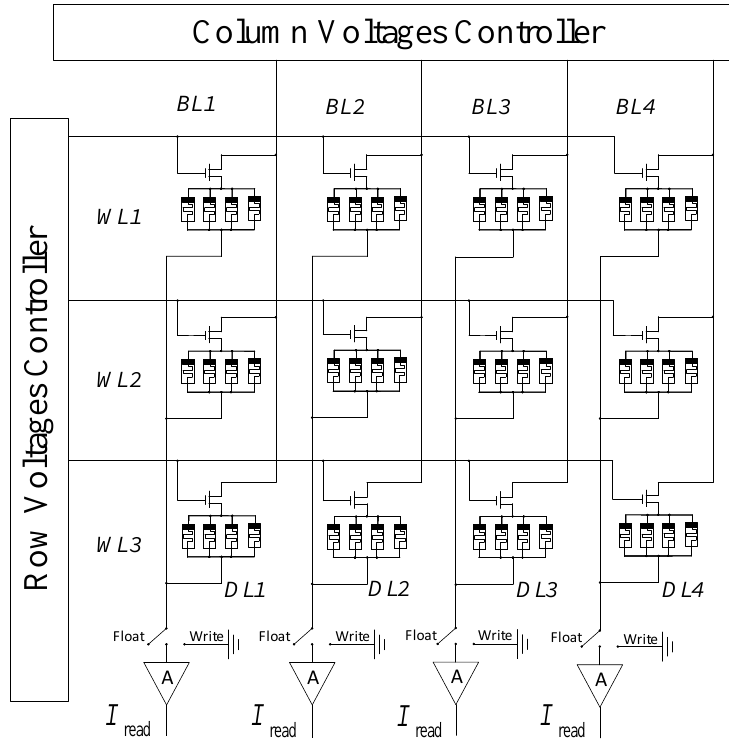
Figure 5. A 3 × 4 crossbar array architecture